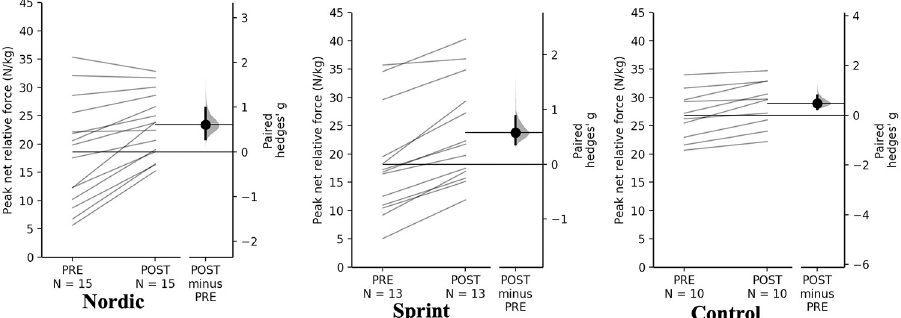
Fig 9. Gardner-Altman estimation plots identifying Pre- and Post-intervention individual changes for peak net relative force and Hedge’s g effect size with the 95% CI indicated by the ends of the vertical error bar.